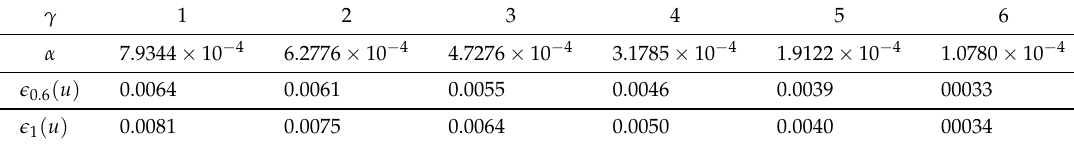
Table 3. k = 0.5, ε = 0.01, the relative root mean square errors for various γ at y = 0.6,1.